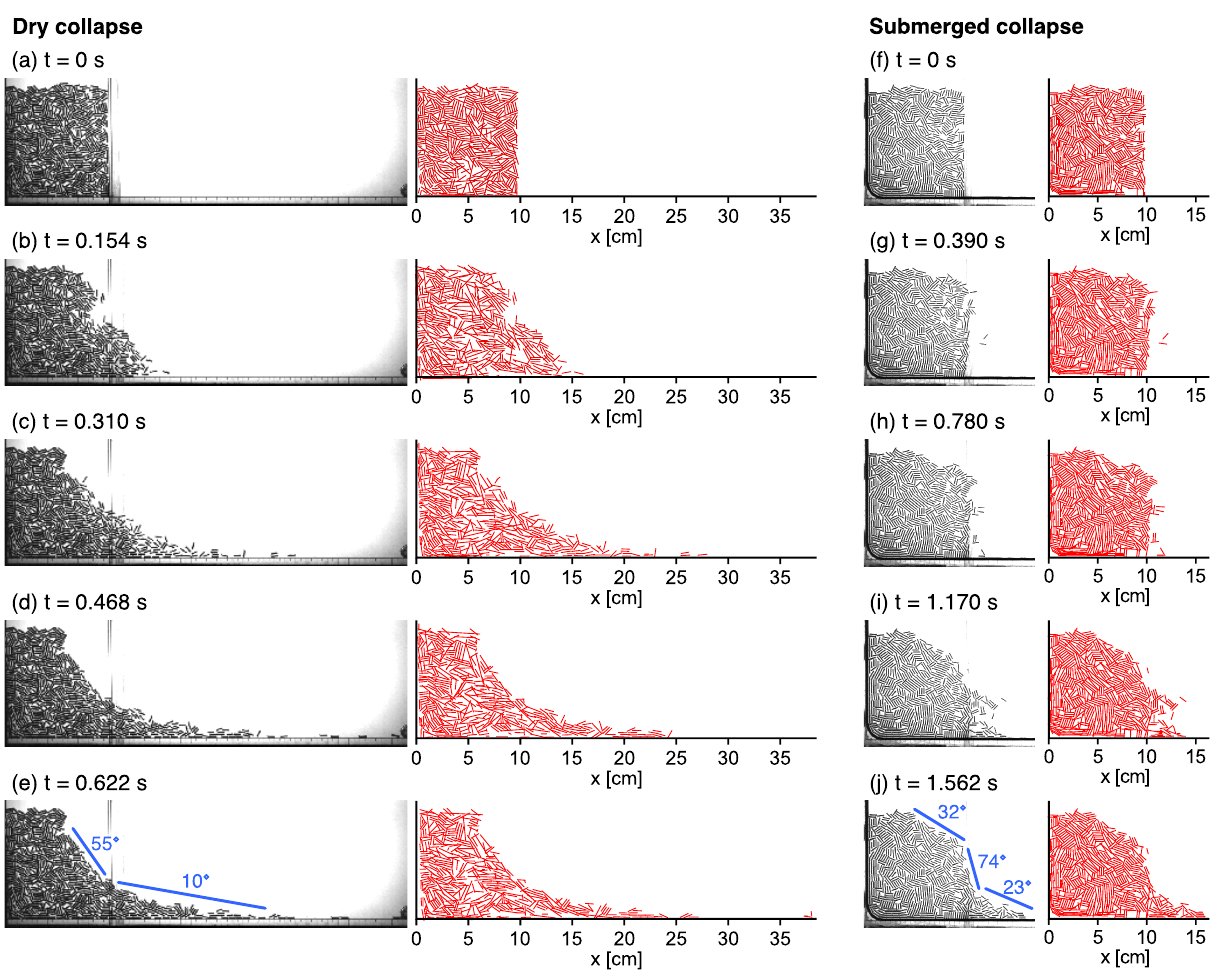
Figure 2. Collapse sequence of a granular column with elongated particles. (a-e) dry column; and (f-j) submerged column. The grey-scale images are photographs from the experiment and the red markers show the grain orientations identified by the digital image analysis. The blue lines indicate the di ↵ erent slopes at the deposit surface